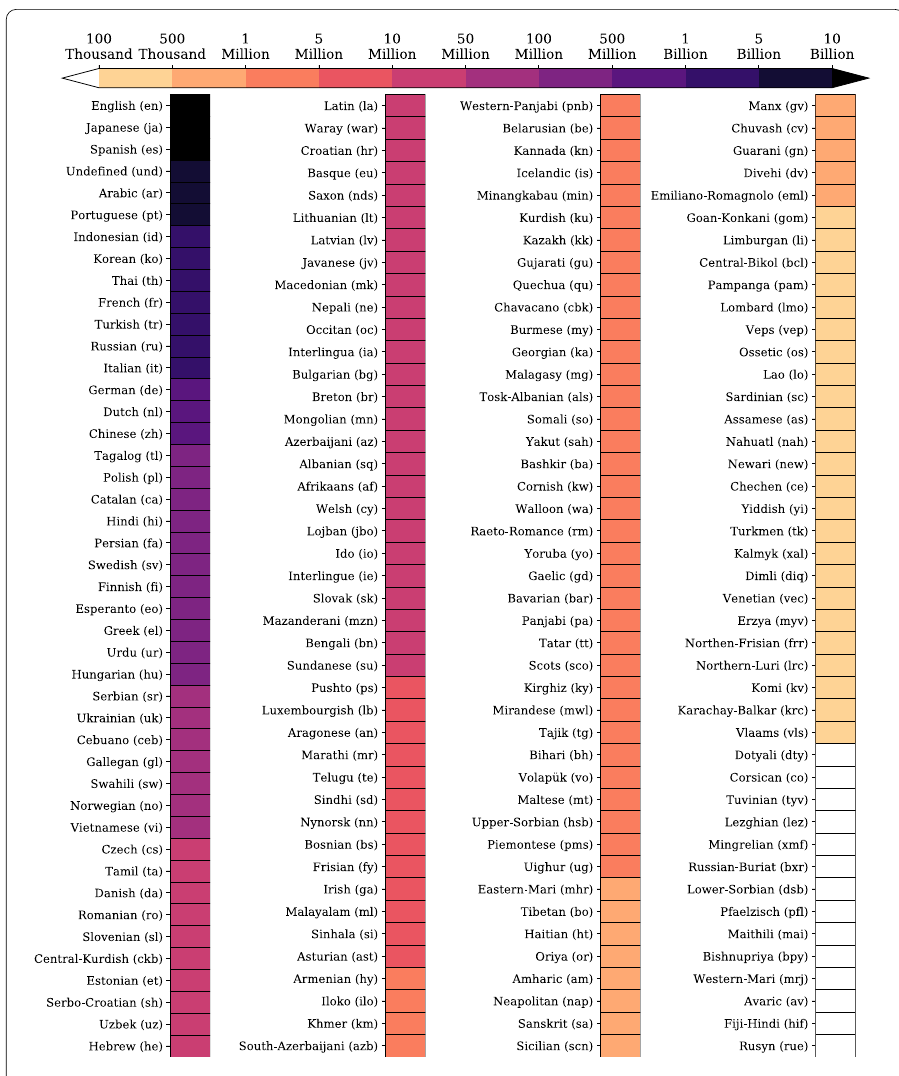
Figure 2 Overall dataset statistics. Number of messages captured in our dataset as classified by the FastText-LID algorithm between 2009-01-01 and 2019-12-31, which sums up to approximately 118 billion messages throughout that period (languages are sorted by popularity). This collection represents roughly 10% of all messages ever posted